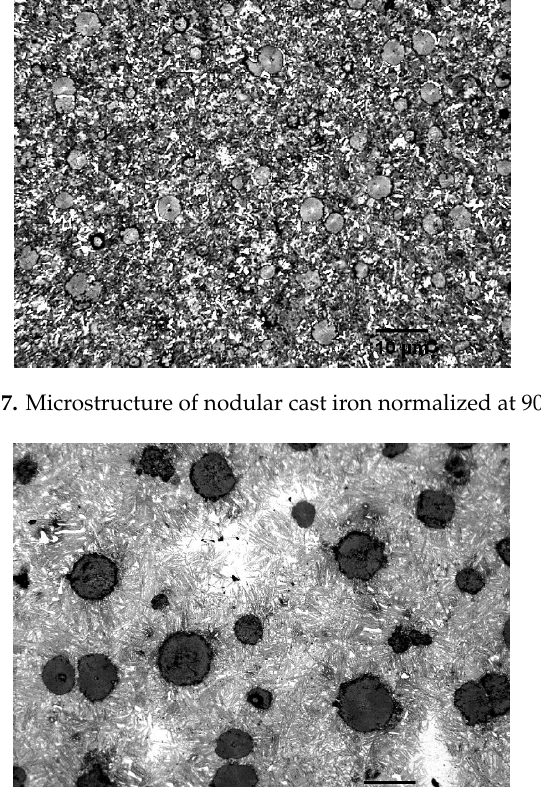
Figure 8. Microstructure of ductile cast iron isothermal quenched at 900 + 250 °C.